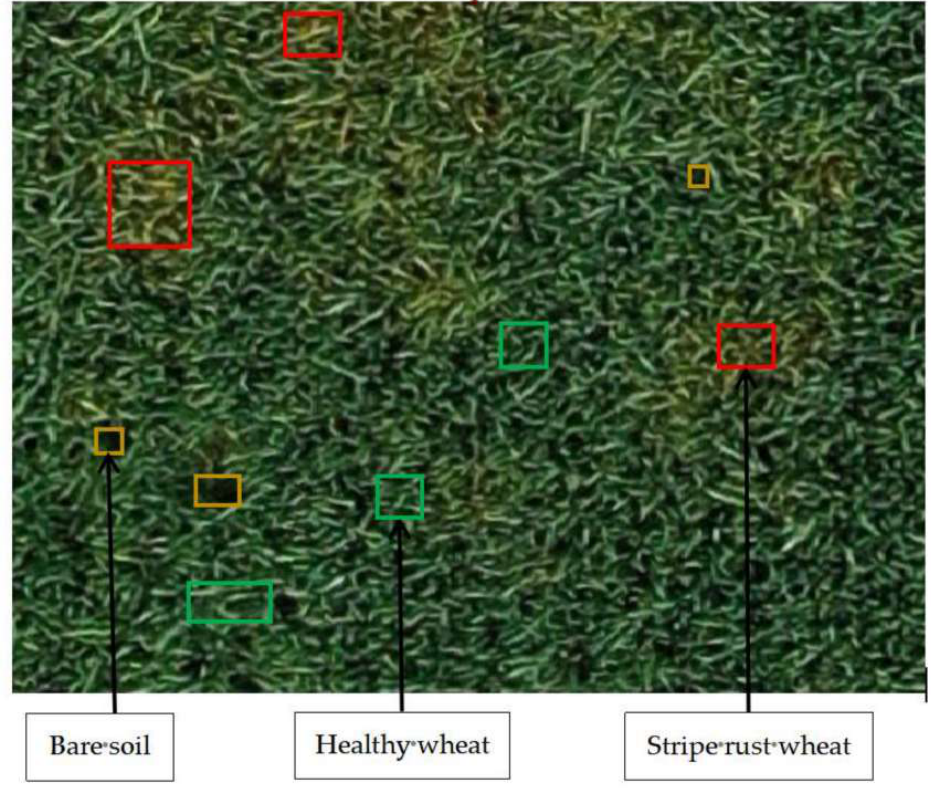
Figure 2. A UAV image with the three categories of samples labeled. The red squares indicate yellow rust wheat, the yellow squares indicate bare soil, and the green squares indicate healthy